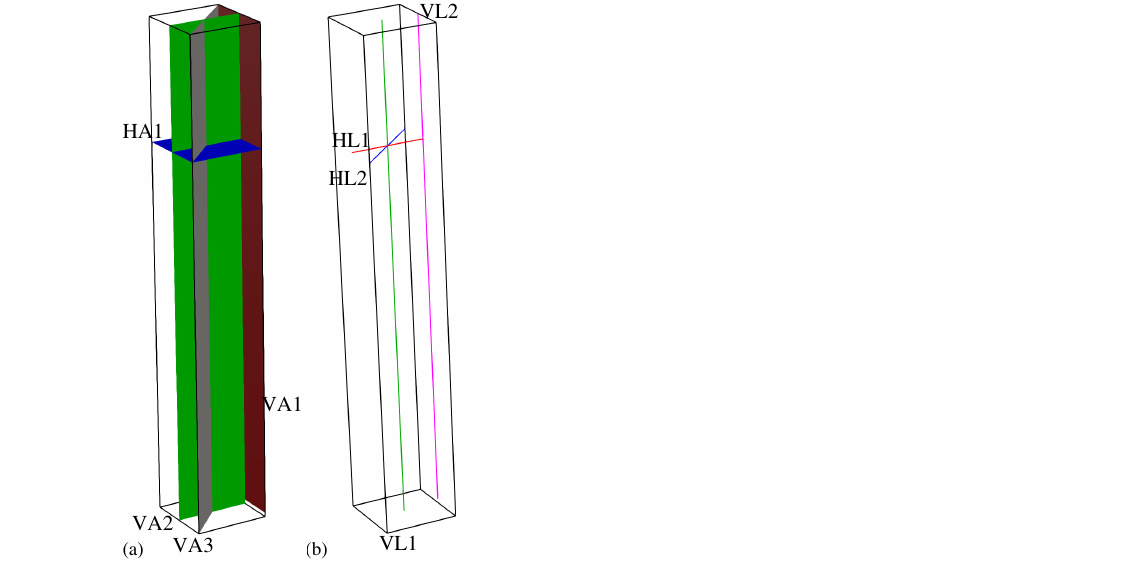
Figure 5. Schematic representation of cross-section planes and lines. ( a ) cross-section planes: blue— HA1 ( xz plane: y = 0.19 m), red—VA1 ( zy plane: x = 0.18 m), gray—VA3 ( y plane: x = z ), green—VA2 ( xy plane: z = 0.09 m). ( b ) Cross-section lines: red—HL1 ( xz plane, y = 0.19 m, z = 0.09 m), blue—HL2 xz plane, y = 0.19 m, x = z , green—VL1 ( xy plane, x = 0.09 m, z = 0.09 m), magenta—VL1 ( xy plane, x = 0.18 m, z = 0.09 m).